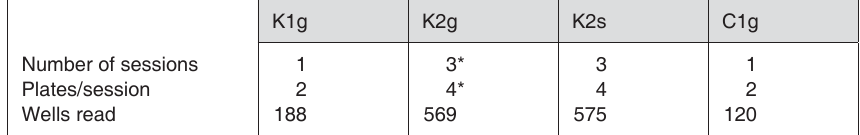
TABLE 1 Sessions and number of microtitration plate wells read for stabilates stored on